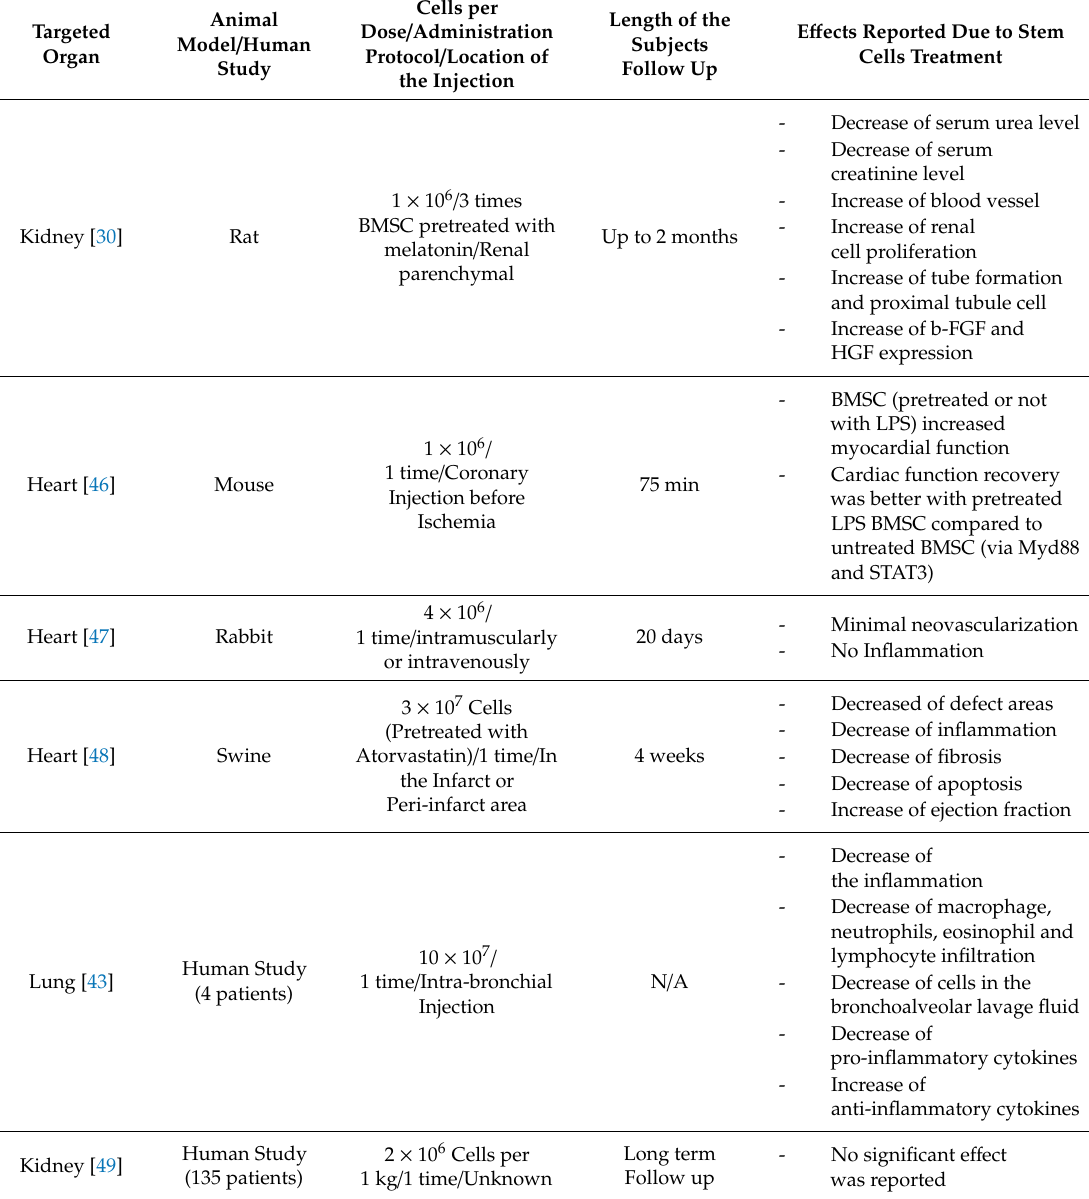
Table 1. Bone Marrow Stem